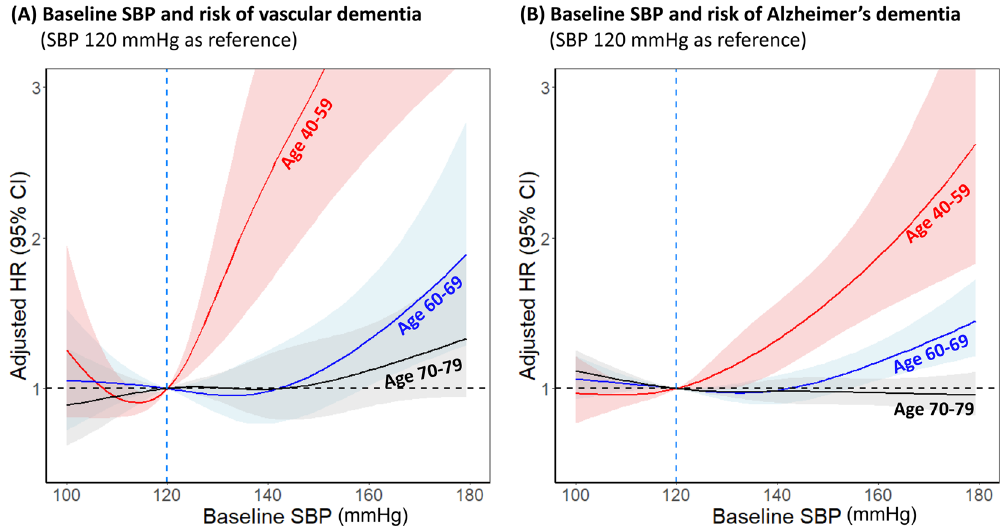
Figure 4. Adjusted HRs for risk of ( A ) vascular and ( B ) Alzheimer’s dementia according to baseline SBP measured in different age subgroups. Subjects with baseline SBP 120 mmHg were used as reference. Spline curves represent HRs adjusted same as Fig. 3. Abbreviations as in Fig.